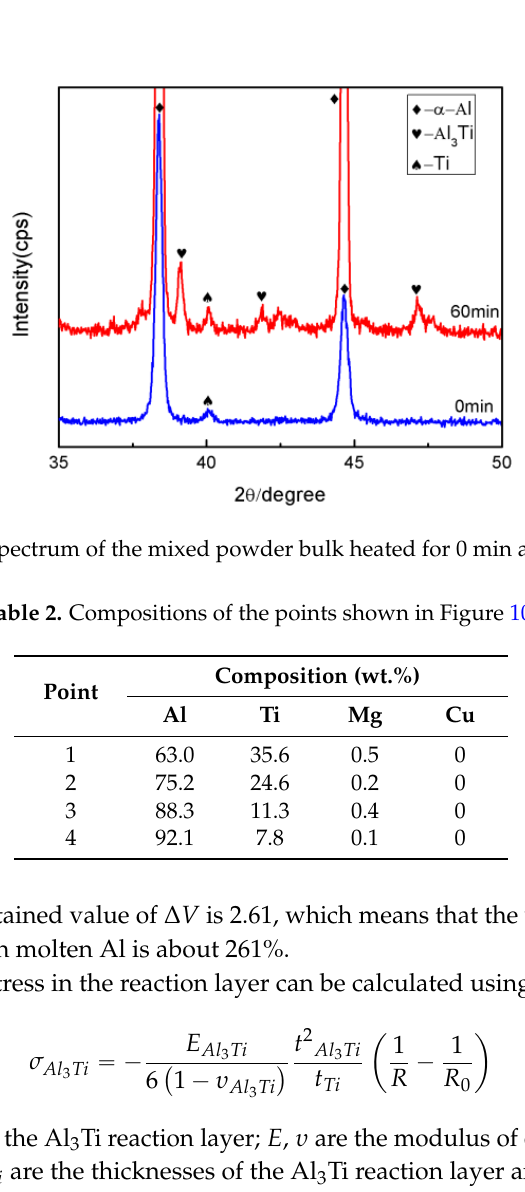
Table 3. Molar volume and elastic modulus of Al, Ti (for the bulk material at room temperature), and the TiAl 3 alloy